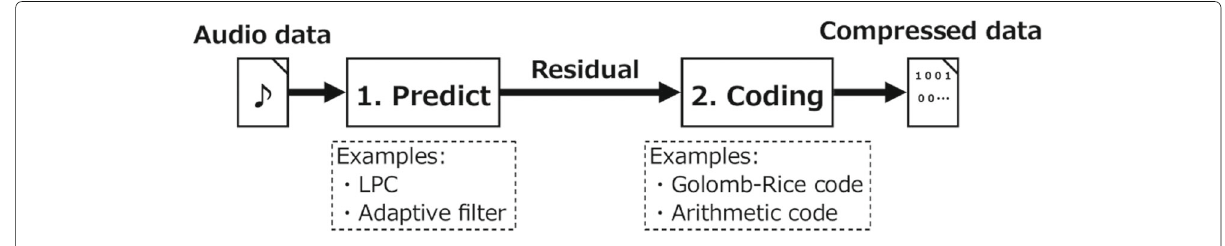
Fig. 1 General structure of lossless audio